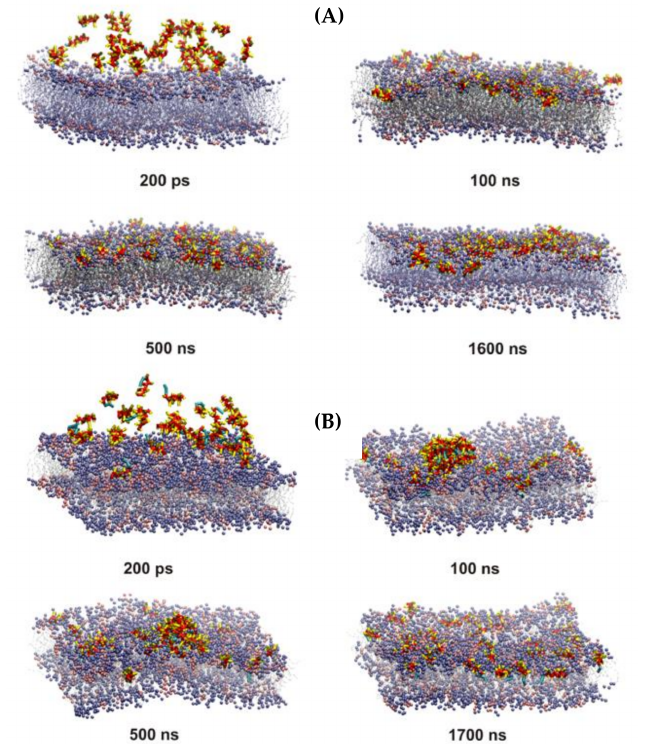
Figure 7. Snapshots from the 1:3 POPE:POPG binding simulations for C5-DK5 ( A ), C12-DK5 ( B ). Valeryl and lauroyl tails are colored cyan, and backbone and side chain beads are colored red and yellow, respectively. Lipid tails are colored gray, while lipid head groups are colored ice-blue and pink for POPG and POPE,